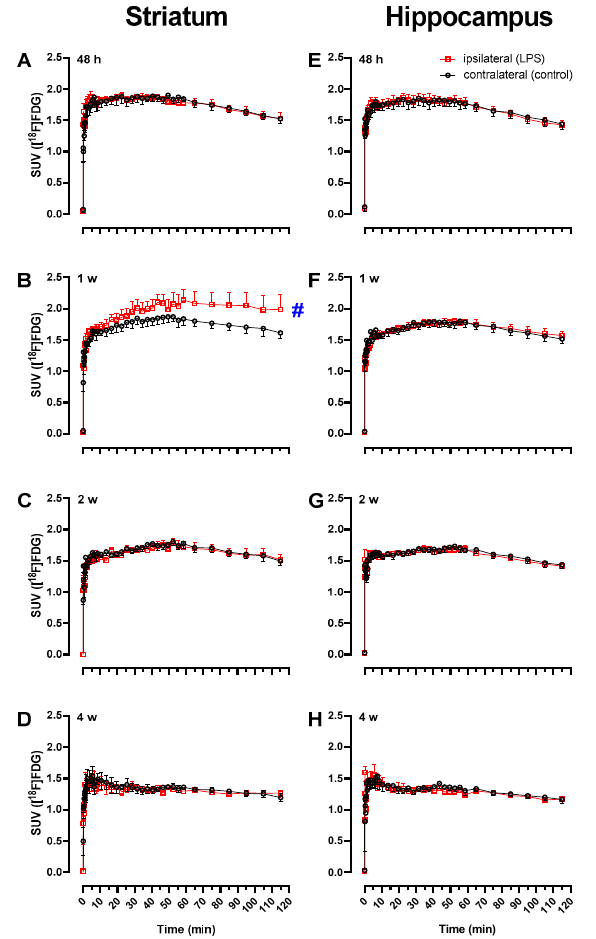
Figure 5. Time–activity curves (TACs) of [ 18 F]FDG in striatum and hippocampus of male rats injected unilaterally with lipopolysaccharide (LPS) in the right striatum. Average TACs ( ± SEM) of [ 18 F]FDG in ipsilateral and contralateral side of striatum ( A – D ) and hippocampus ( E – H ) at 48 h ( n = 4), 1 week ( n = 4), 2 weeks ( n = 4), or 4 weeks ( n = 3) post-LPS injection. # p = 0.05, right vs. left striatum at 1 week (repeated measures ANOVA).